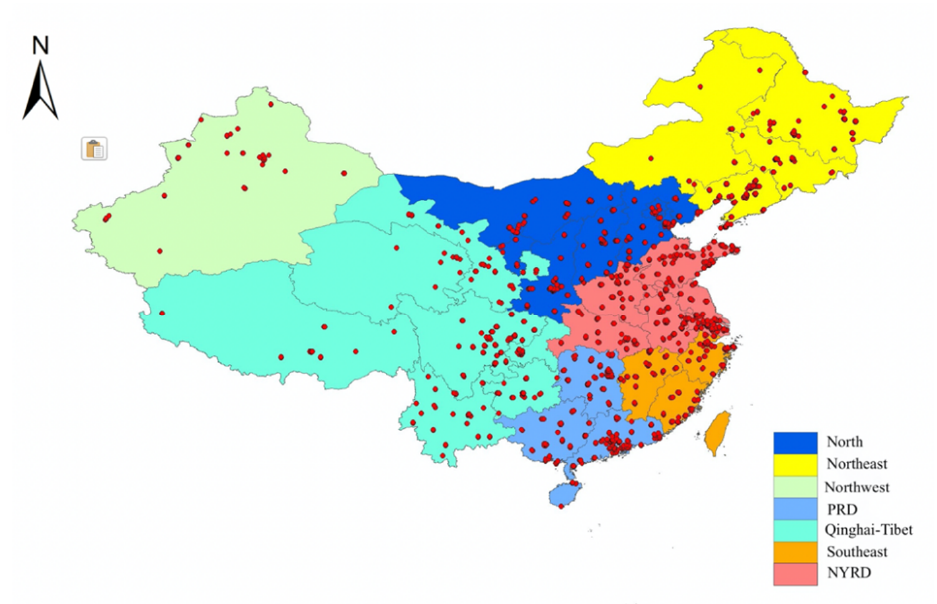
Figure 2. Seven subregions covering the study domain and spatial distribution of fine particulate matters (PM 2.5 ) monitoring sites involved in this study. ArcGIS software was used for spatial cluster analysis (version 10.7.1).